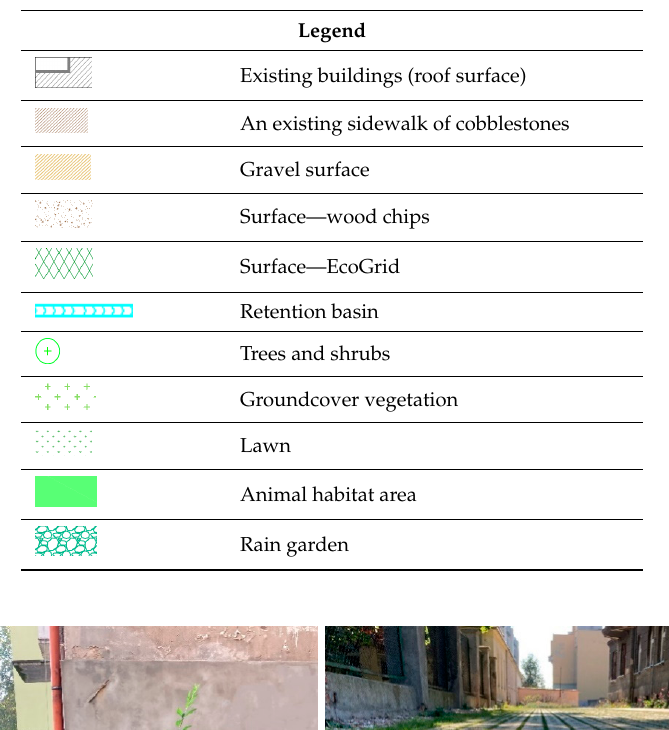
Figure 1. Spatial development project for Area No. 1. (Source: Municipality of Wroclaw, author of the project Form.ica Sp. z o.o.).